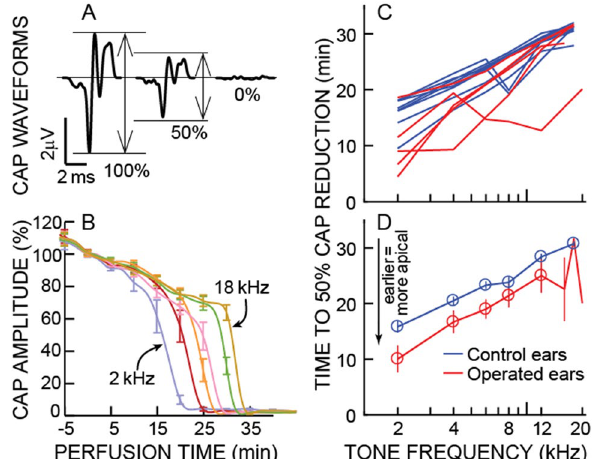
Figure 1. The effects of perfusing kainic acid in artificial perilymph from the low-frequency cochlear apex to the high-frequency cochlear base. ( A ) Example auditory-nerve compound-action-potential (CAP) waveforms at the start of a perfusion (100%), when CAP reduced to 50%, and at the end of the perfusion (0%). ( B ) CAP amplitudes (means from the 8 un-operated control ears, normalized by the average value − 5 to 5 min re perfusion start) evoked by low-level tone bursts (10 dB sensation level (SL) with SL determined by the CAP threshold at each frequency) as functions of time after the start of the perfusion. Error bars represent 1 standard error of the mean (SEM). Color-coded lines show tone-burst frequencies of 2, 4, 6, 8, 12 and 18 kHz. These were reduced in low-to-high sequence (left to right in the figure). ( C ) The perfusion times that produced 50% CAP amplitude reductions as functions of tone frequency. Each line is from one ear: red = operated ears, blue = control. ( D ) Lines show the averages of the data from panel C. Circles indicate the averages are from all ears of a group. Error bars represent 1 SEM (needs at least 2 values). A reduction that is 5 min earlier than normal corresponds to a ~ 1 octave more apical CF location in a normal cochlear